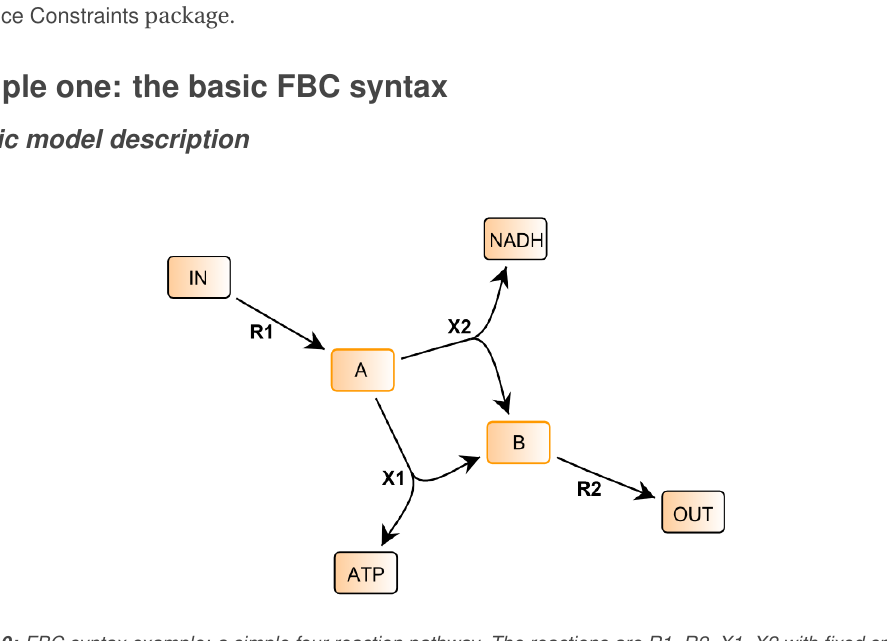
Figure 10: FBC syntax example: a simple four reaction pathway. The reactions are R1, R2, X1, X2 with fixed species IN, OUT, ATP, NADH and variable species A, B.